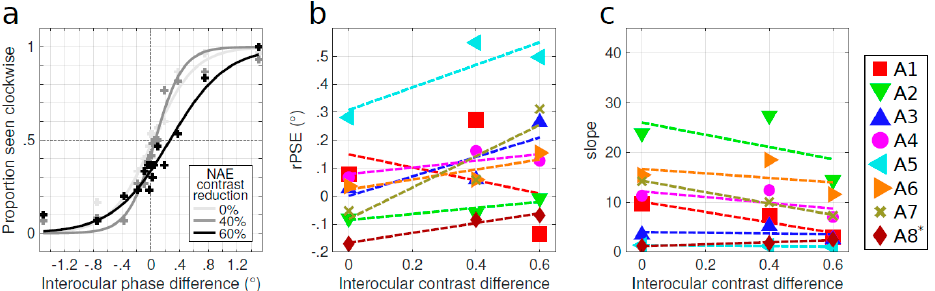
Figure A3. Interocular contrast difference. ( a ) Psychometric functions of the perceived direction of rotation for one amblyopic subject (A7) as a function of the interocular phase difference for three contrast conditions. Contrast was decreased in the non-amblyopic eye (NAE) image: 0% (light-gray symbols), 40% (mid-gray symbols), and 60% (dark-gray symbols) reduction. Data points are fitted by a logistic function. ( b ) rPSE as a function of the interocular contrast difference for the eight amblyopic subjects. *rPSE values for subject A8 were divided by 10. ( c ) Slopes of the psychometric functions. Dashed lines represent linear regression. Quality of fit and regression parameters are reported in Table S1 (Supplementary Materials, Sheet 5).